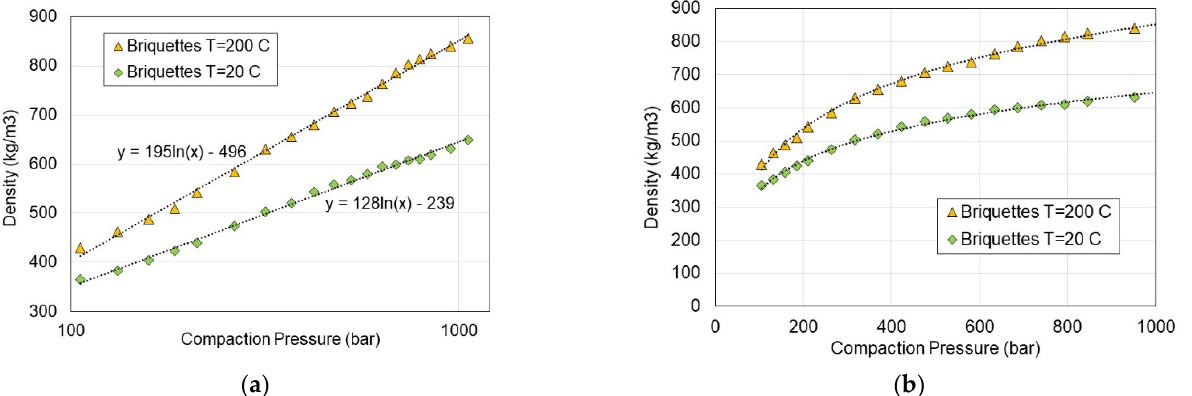
Table 1. Coefficients of Equation (13) and the regression coefficient R 2 .